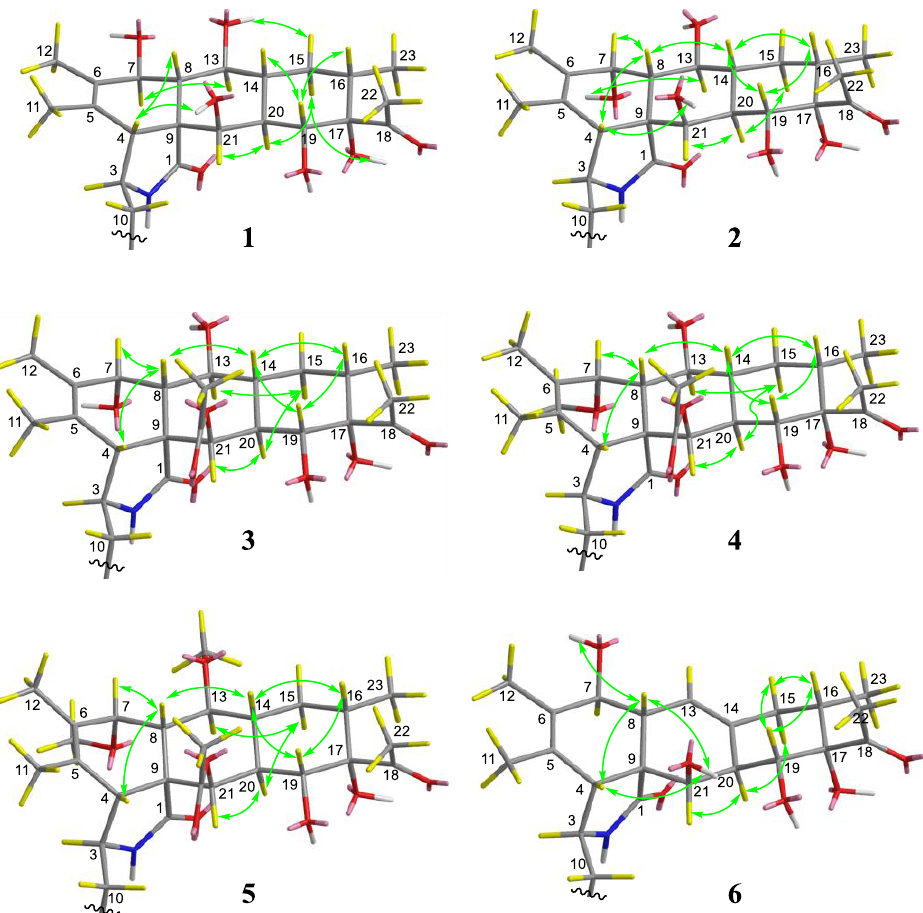
Figure 4. Key NOESY correlations of compounds 1 – 6. Table 3. The 1 H NMR data (600 MHz) of compounds 4 – 6 ( δ in ppm, J in Hz).